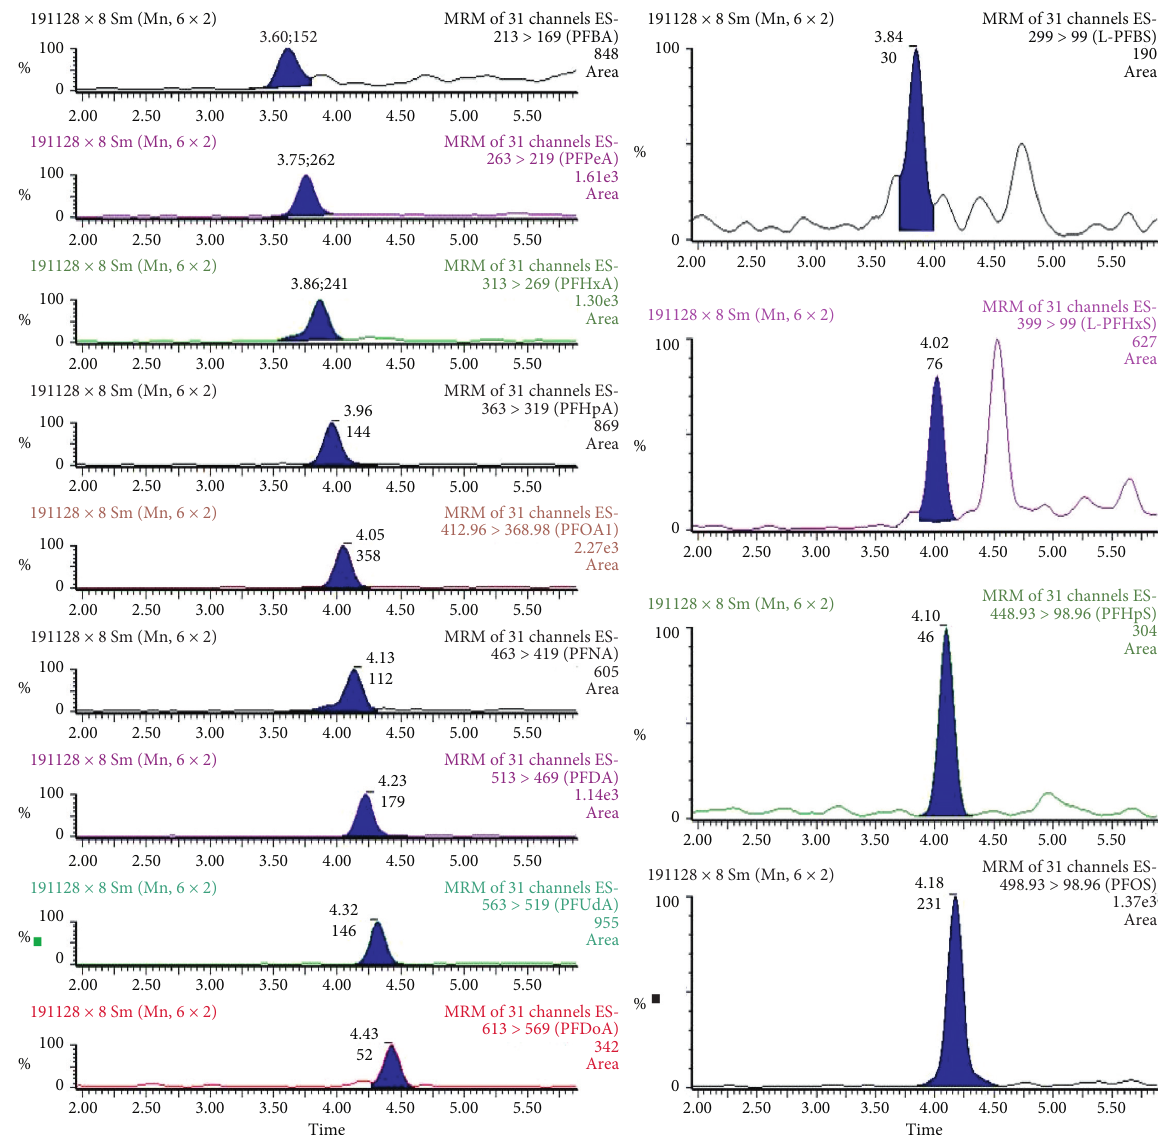
Figure 3: Chromatogram (MRM) of a real serum sample (perfluorocarboxylic acids (left) and perfluorosulfonate compounds (right) are present in the sample at very low